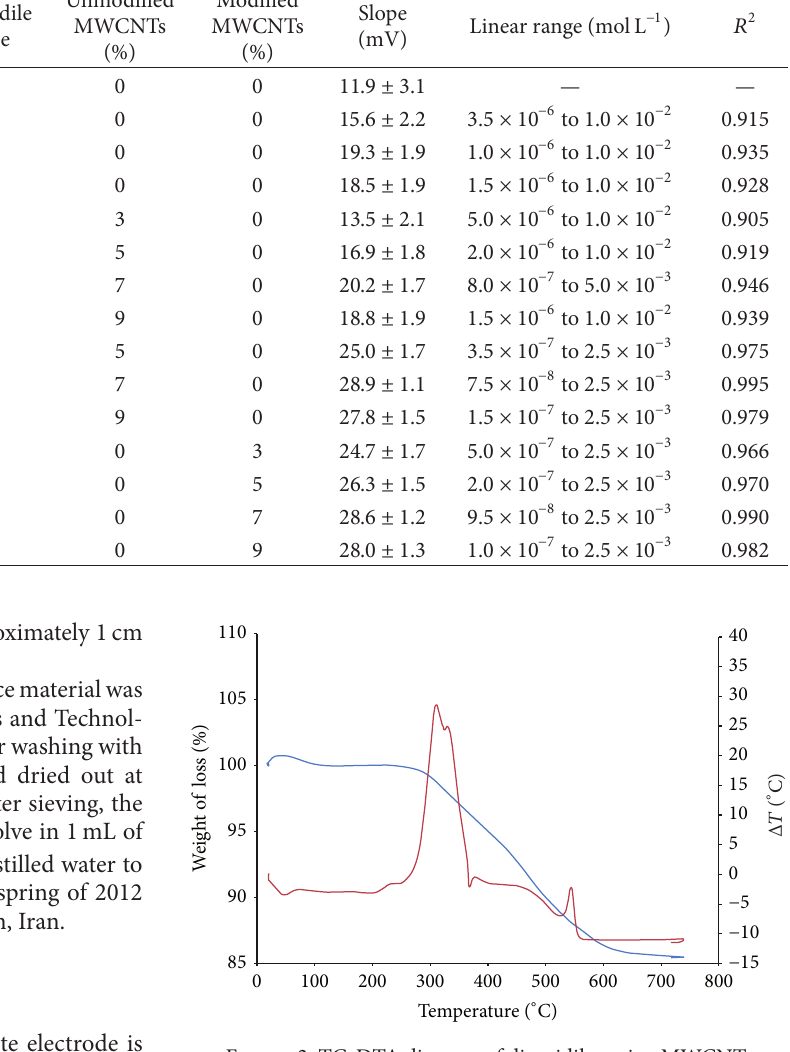
F 2: TG-DTA diagram of dipyridile amine